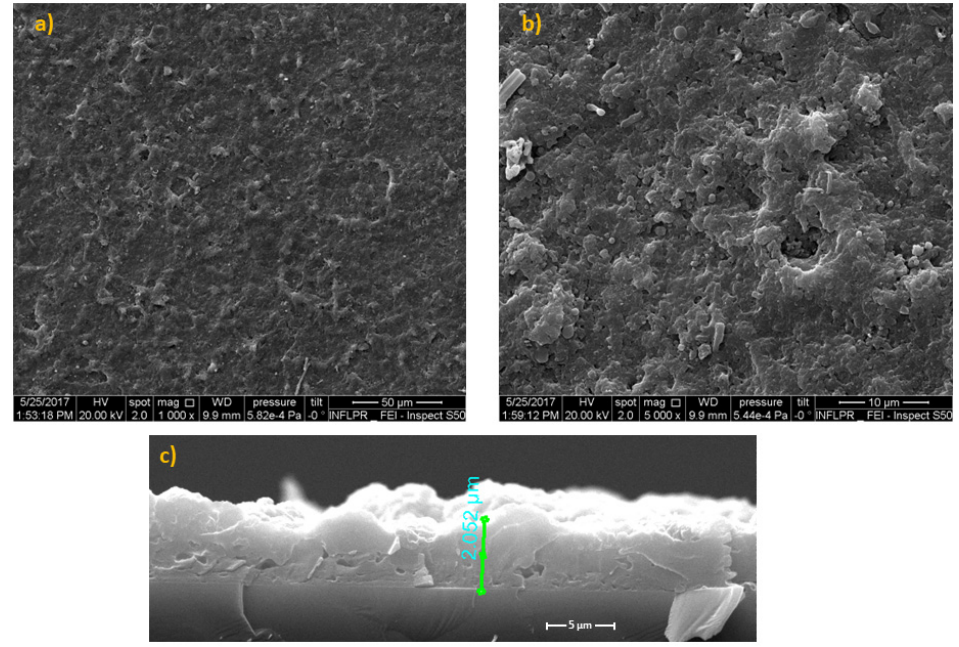
Figure 2. SEM images of BG+CIPRO/PMMA MAPLE films on Si substrates covered with PMMA: ( a ) overview, ( b ) detail, and ( c ) cross-section .